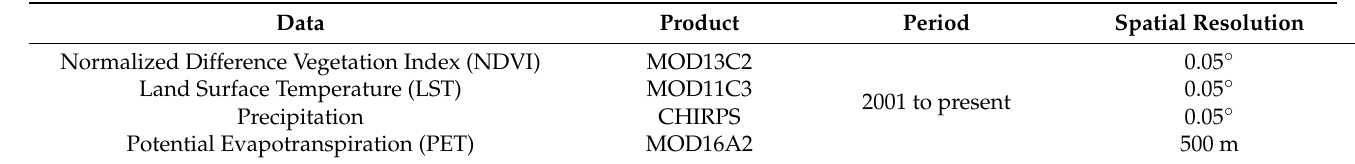
Table 1. Summary of the data used in this